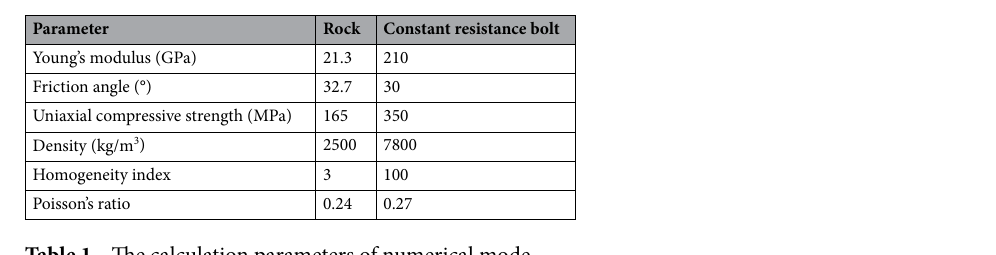
Table 1. The calculation parameters of numerical